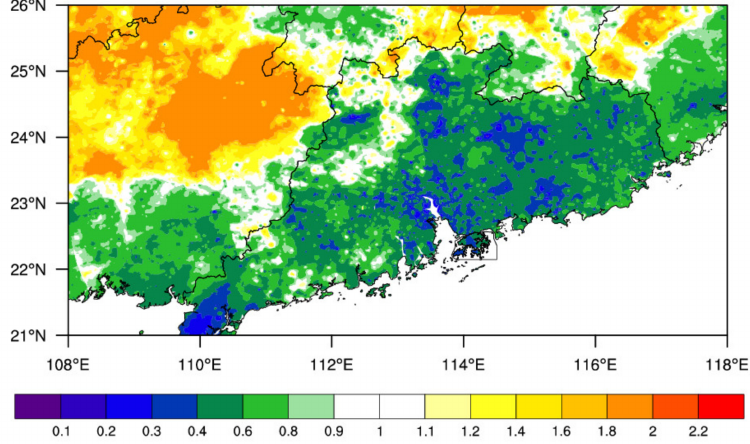
Figure 5. The results o F field correction calculated by means of the climatological scaling